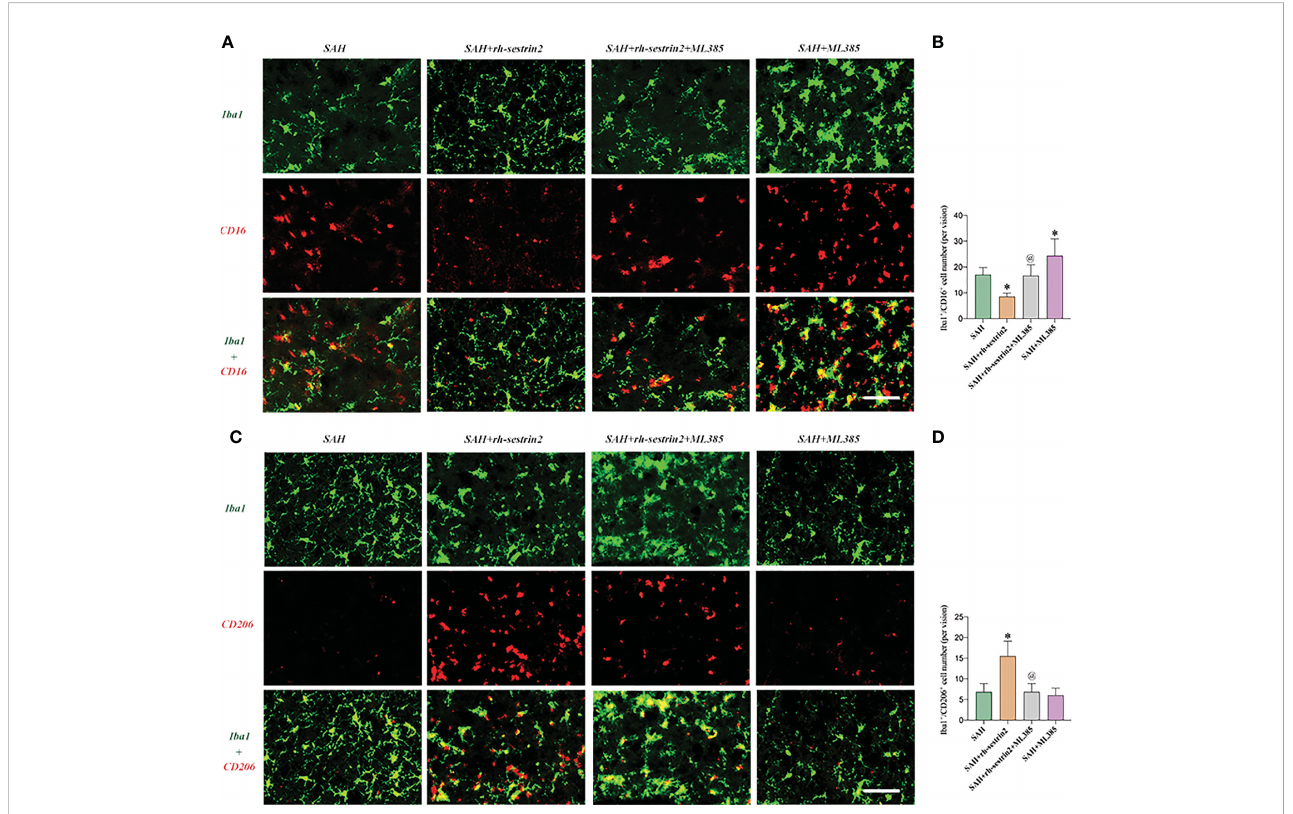
FIGURE 6 ML385 induced M1 microglia polarization and suppressed M2 microglia polarization after SAH. (A) Representative images and (B) quanti fi cations of CD16 + /Iba1 + staining in different groups (n = 6 per group). (C) Representative images and (D) quanti fi cations of CD206 + /Iba1 + staining in all groups (n = 6 per group). * P < 0.05 versus SAH group. @ P < 0.05 versus SAH + rh- sestrin2 group. Data indicated as mean ± SD. Scale bars = 50 m